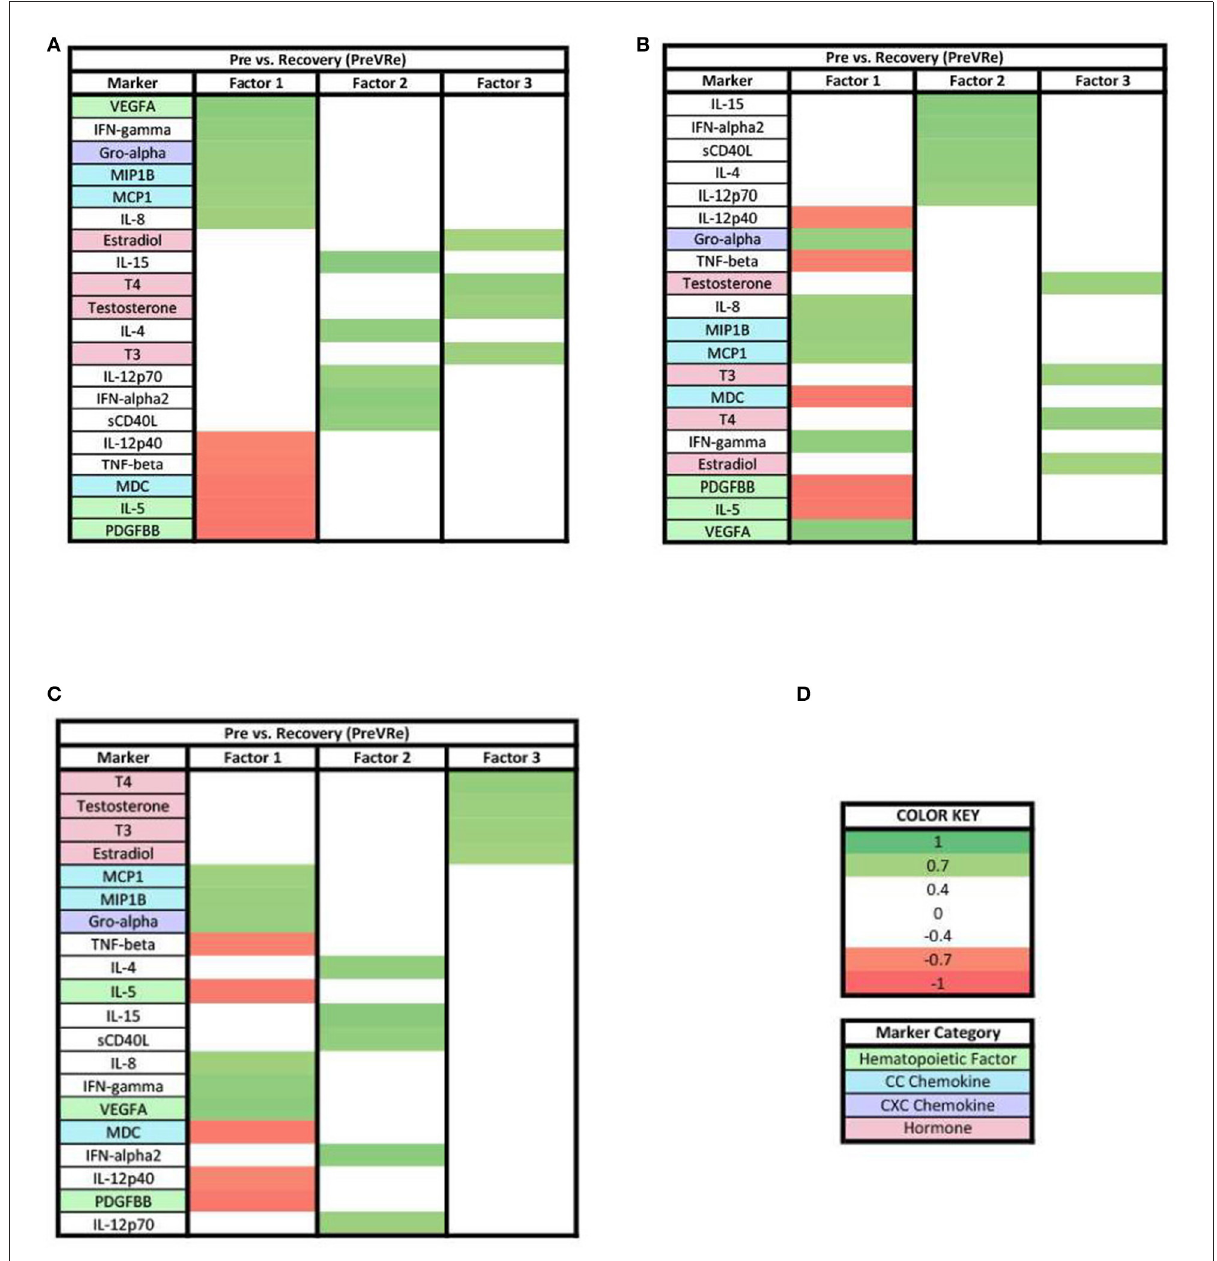
FIGURE7 Heat maps of the post-stress vs. recovery (PreVRe) analysis of loadings ≥ 0.7. (A) Biomarkers sorted from highest to lowest loading in PreVRe factor 1. (B) Biomarkers sorted from highest to lowest loading in PreVRe factor 2. (C) Biomarkers sorted from highest to lowest loading in PreVRe factor 3. (D) Color key for PreVRe loadings ≥ 0.7, sorted top to bottom from most positive to most